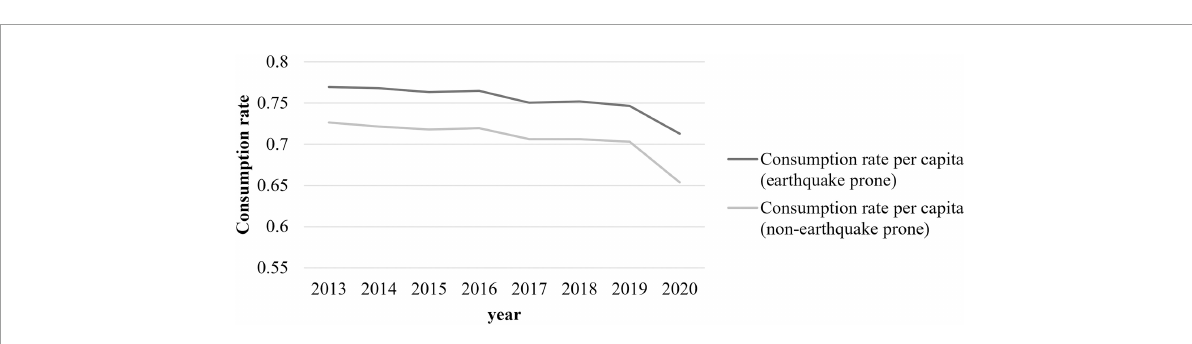
FIGURE3 Comparison of per capita consumption rate between earthquake-prone regions and non-earthquake-prone regions (The per capita consumption rate is calculated using per capita consumption expenditure per resident/per capita disposable income of residents in each